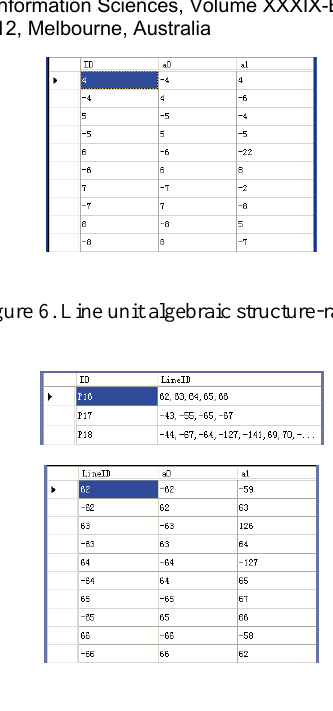
Figure 7. Polygon unit algebraic structure-GDP per capita